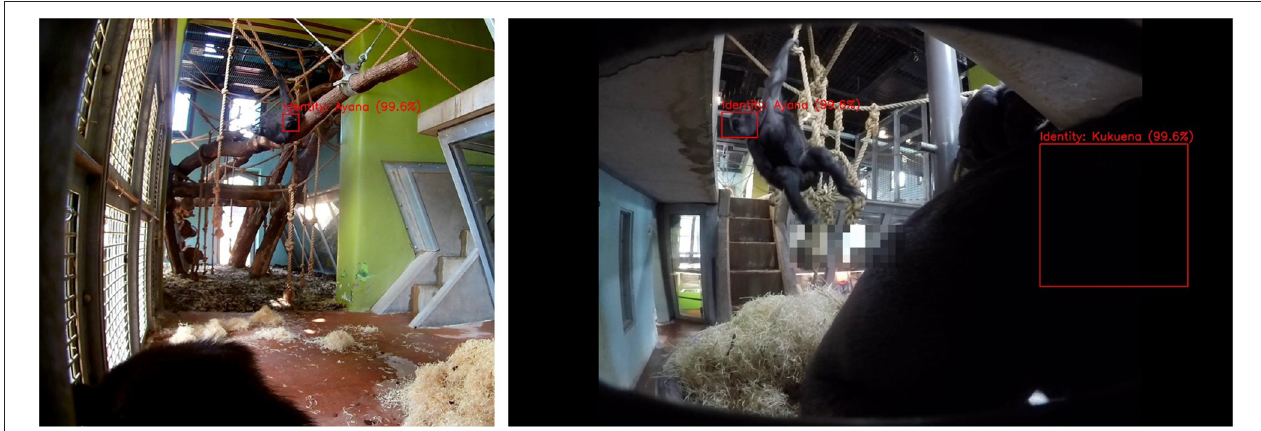
FIGURE 9 | The figure shows cases where the detections do not represent true instances of interaction with the Gorilla Game Lab device. The image on the left shows a scenario where the gorilla interacting with the device is not detected due to crouching but the observing gorilla is. The image on the right shows simultaneous detection of the engaging gorilla and the observing juvenile gorilla.